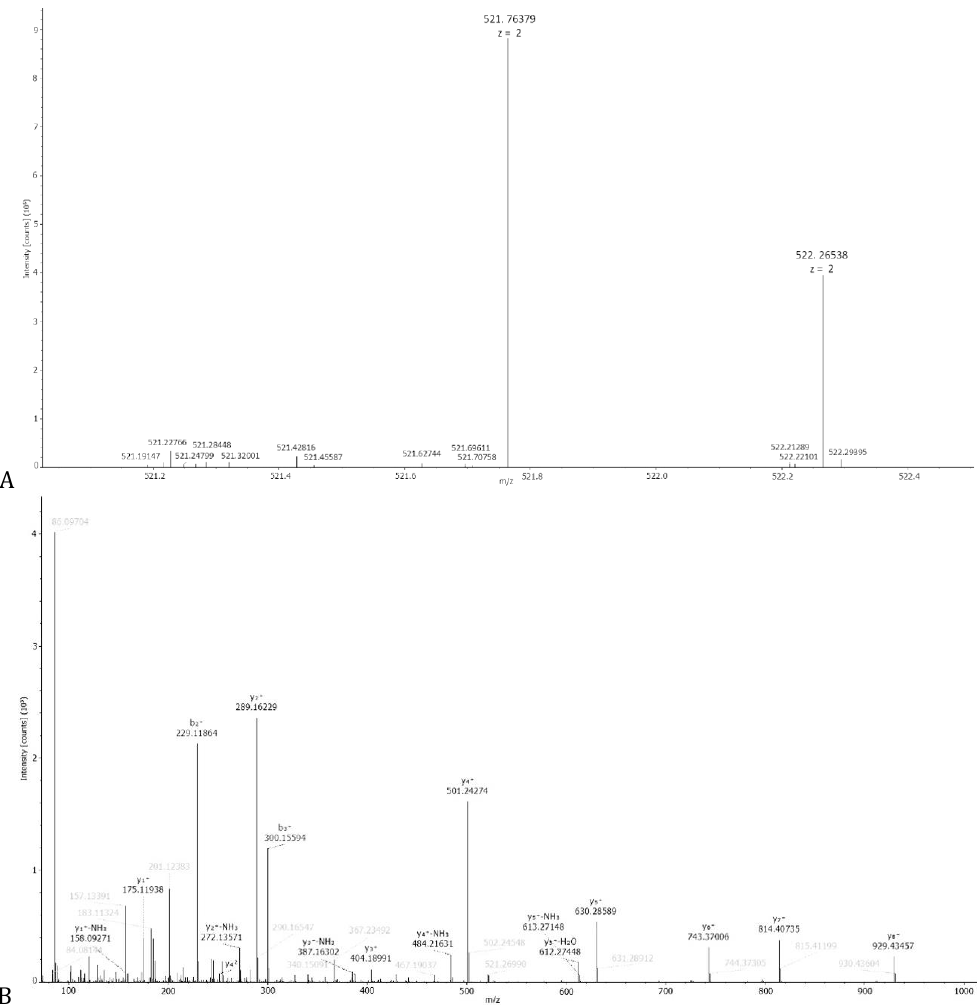
Figure 5. MS spectra of peptide number 3 of the pH 4 fraction of R. communis seed protein hydrolysate. MS 1 identifies the isotopic pattern of the peptide ion (a), whereas MS 2 identifies the b + and y + ions from the peptide fragmentation data (b). Table II. Characteristics of the peptides of the pH 4 fraction of the jatropha seed protein hydrolysate